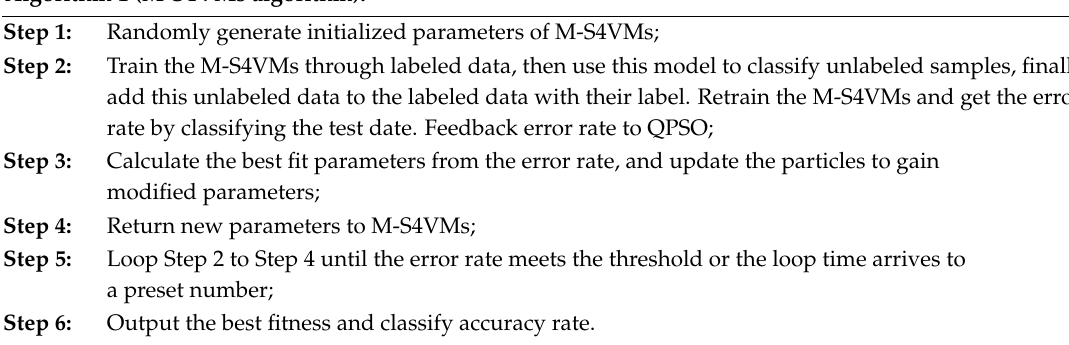
Algorithm 1 (M-S4VMs algorithm):